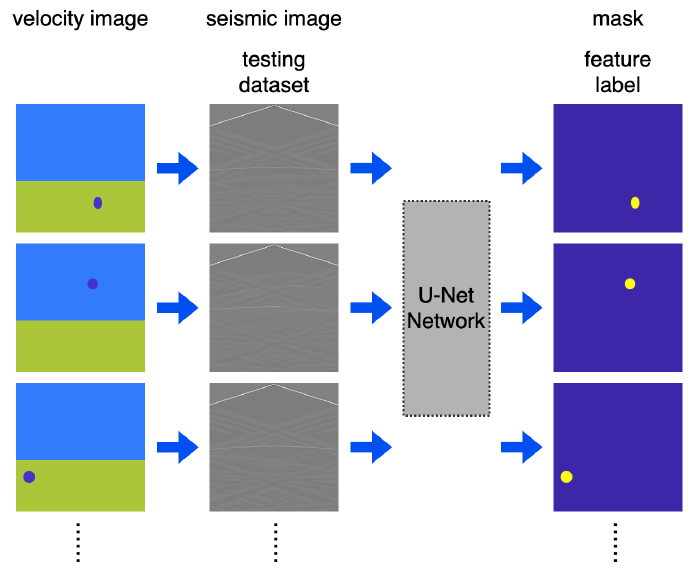
Figure 3. Verification